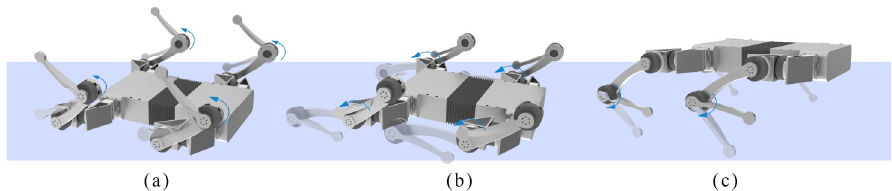
Figure 12. Forward motion direction: turning over after capsizing: ( a ) Actuator 4 drives the calf to approach the thigh; ( b ) Actuator 3 drives the thigh and calf to approach the ground; ( c ) Actuators 3 and 4 work together to drive the thigh and calf to slowly support the whole robot.